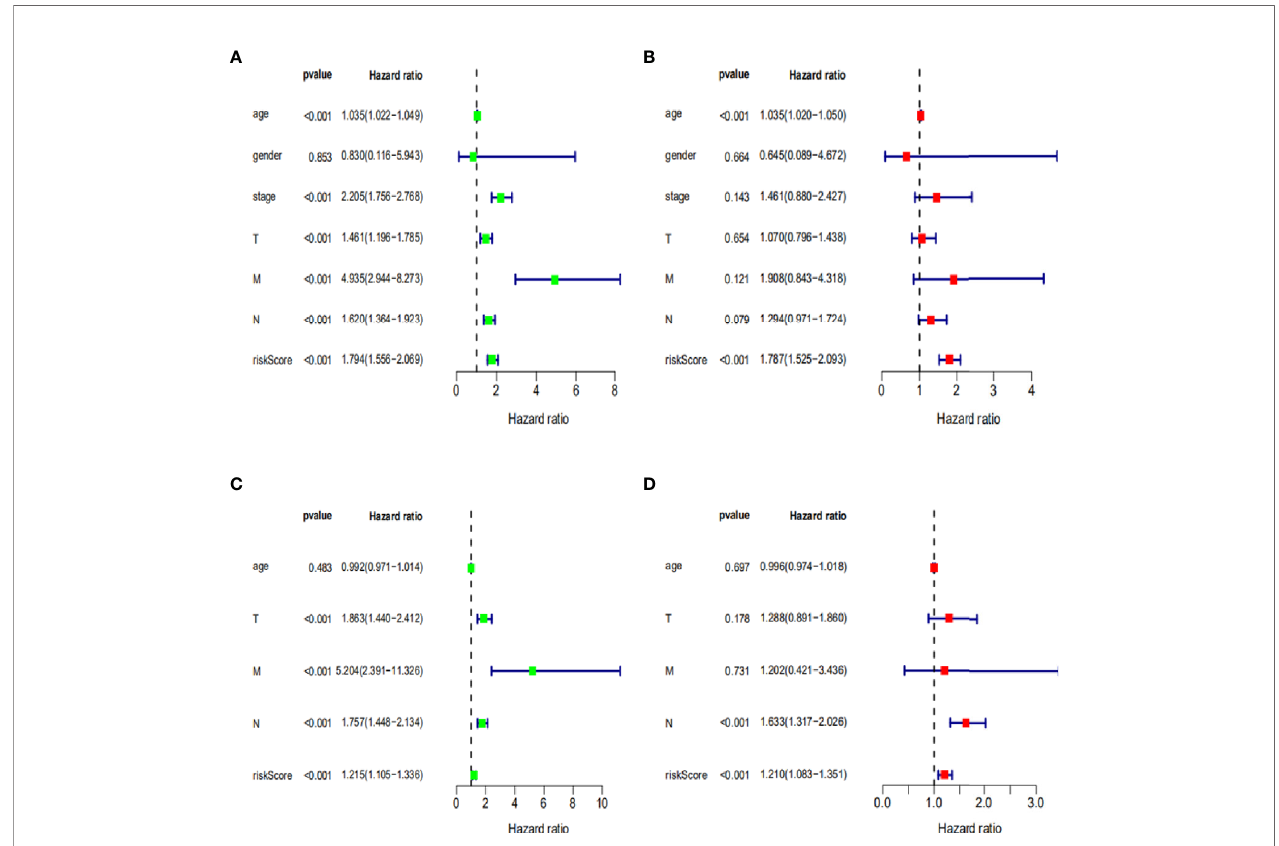
FIGURE 6 | Cox regression analysis of clinical characteristics related to OS in training dataset and testing dataset. (A, B) Univariate and multivariate Cox regression analysis of clinical characteristics related to OS in training dataset. (C, D) Univariate and multivariate Cox regression analysis of clinical characteristics related to OS in testing dataset.